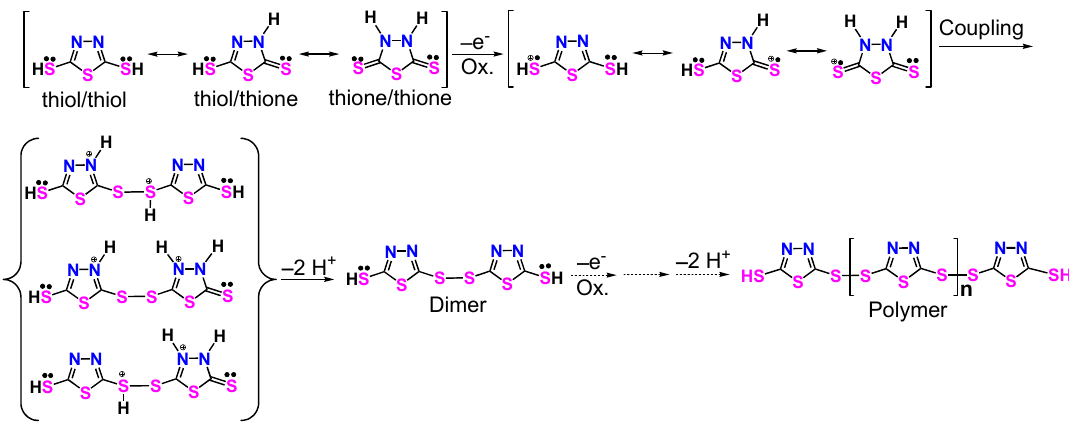
Figure 5. ( a ) XPS wide scan spectra of BT, PBT, and Hg 2+ -loaded PBT, and high-resolution XPS spectra of ( b ) Hg 4f, ( c ) C 1s, ( d ) N 1s, and ( e ) S 2p.